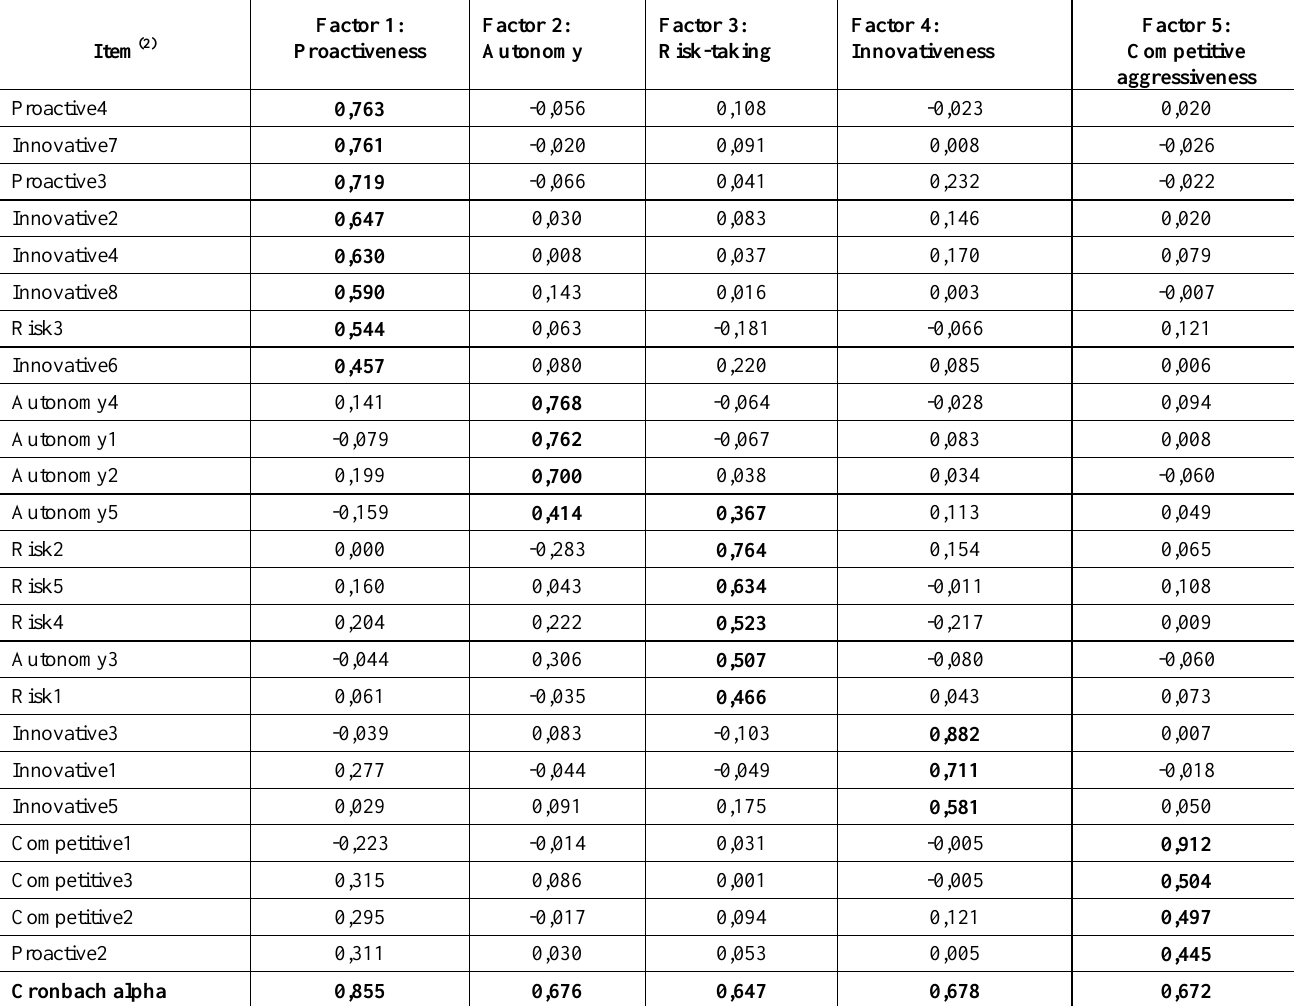
Table 2: Oblimin rotated factor matrix: Independent variables